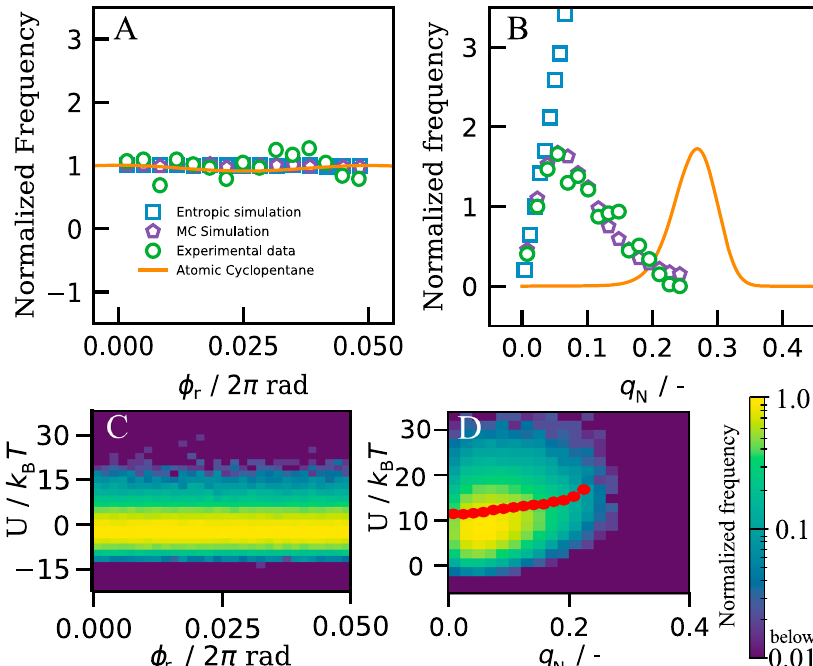
Fig. 3 Distributions of puckering con fi gurations. A Normalized frequency of the reduced puckering phase angle, ϕ r from envelope ( ϕ r = 0) to twist conformation ( ϕ r = 0.05 ⋅ 2 π rad). The fl at distribution reveals no preference for a particular conformation. B Frequency f ( q N ) of the normalized puckering amplitude q N : experimental data (green circles), Monte Carlo simulations of freely joint particles (blue squares), and particles interacting with an effective critical Casimir potential (purple pentagons), and expected values for atomic cyclopentane as given in ref. 23 , assuming the largest reasonable envelope-to- twist energy barrier (solid orange line). Frequency is normalized to result in identical initial slopes. C , D Probability density maps of total bending energy as a function of ϕ r and q N , respectively, for the simulated patchy particle rings. The logarithmic colourmap indicates the normalized frequency of observation from <0.01 (blue) to 1.0 (yellow). Red circles indicate the average bending energy as determined from the measured distribution of q N . Source data are provided as a Source data fi le.